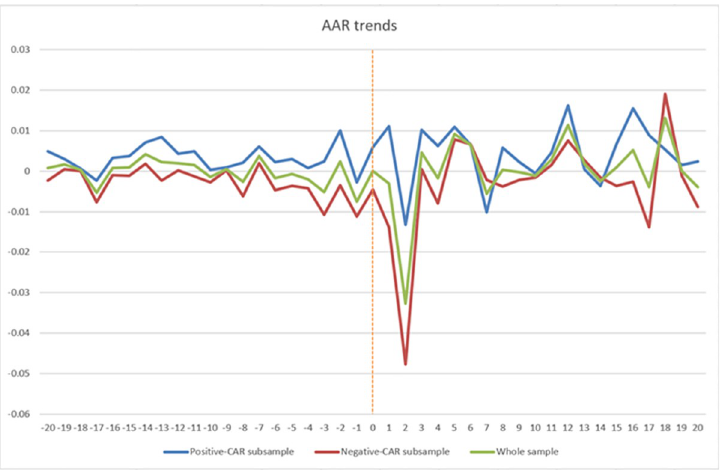
Fig 1. AAR trends over the 41-day event window (-20, +20). Note: The dashed red vertical line indicates the event day (January 23, 2020), and the horizontal axis shows trading days within the event